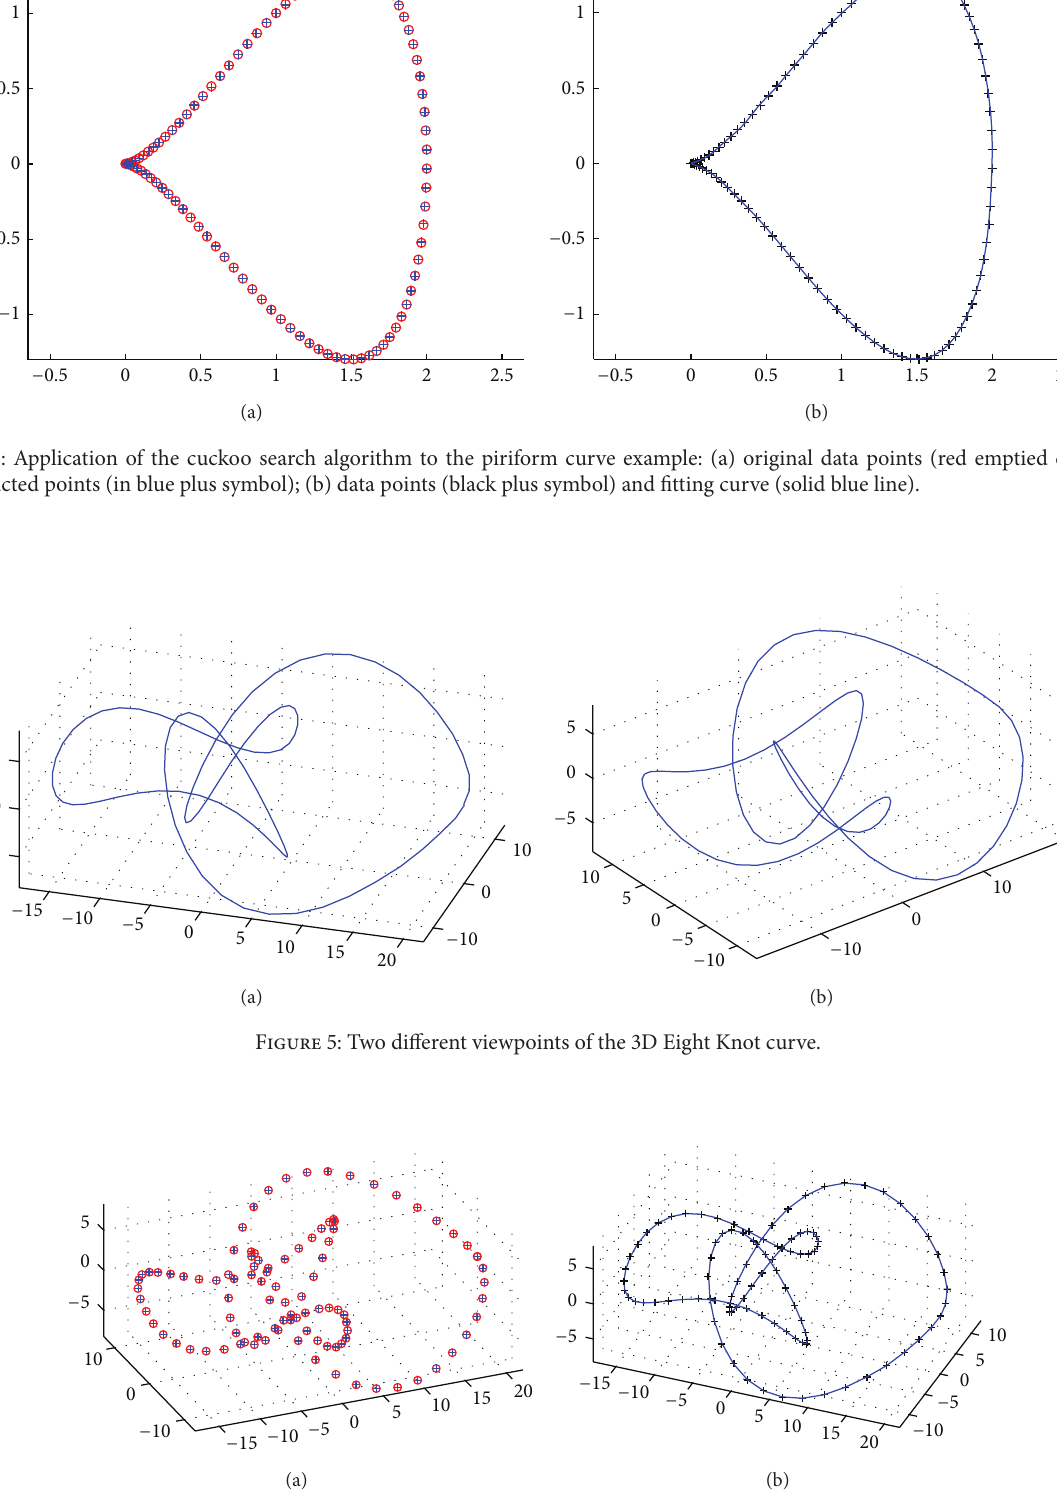
Figure 6: Application of the cuckoo search algorithm to the 3D Eight Knot curve example: (a) original data points (red emptied circles) and reconstructed points (in blue plus symbol); (b) data points (black plus symbol) and fitting curve (solid blue